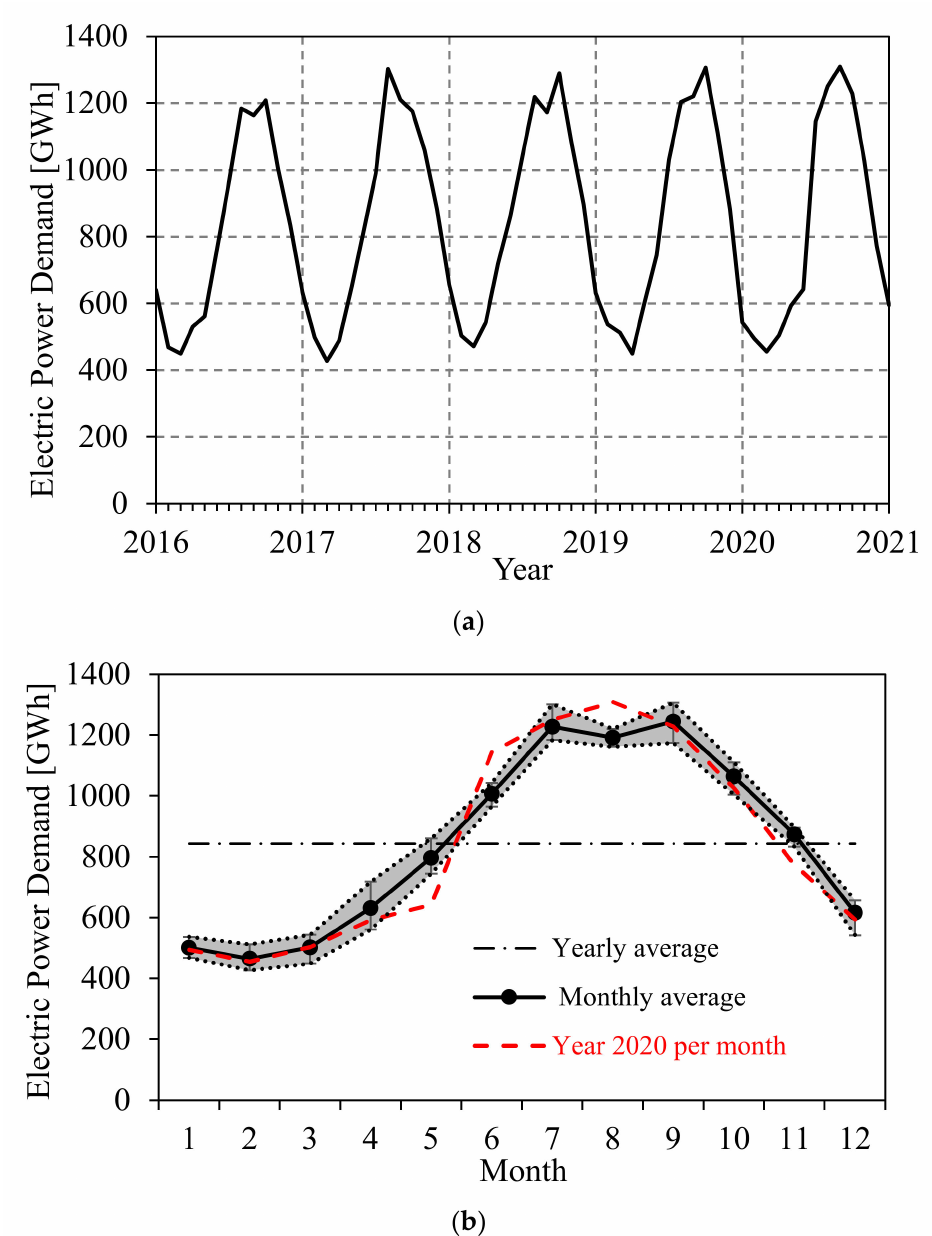
Figure 4. Monthly electric power demand in Sharjah City ( a ) between 2016 and 2019 and ( b ) an analysis of the demand in 2020 in comparison to the previously reported